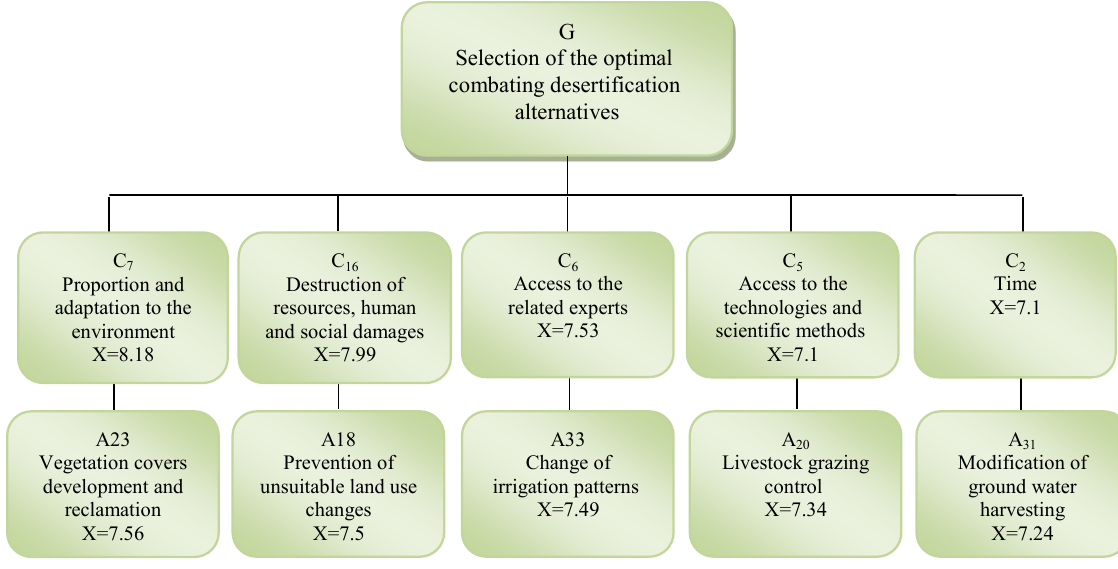
Figure 2. Hierarchical decision structure to select optimal combating-desertification alternatives in study area. Table 8. The criteria importance mean according to the